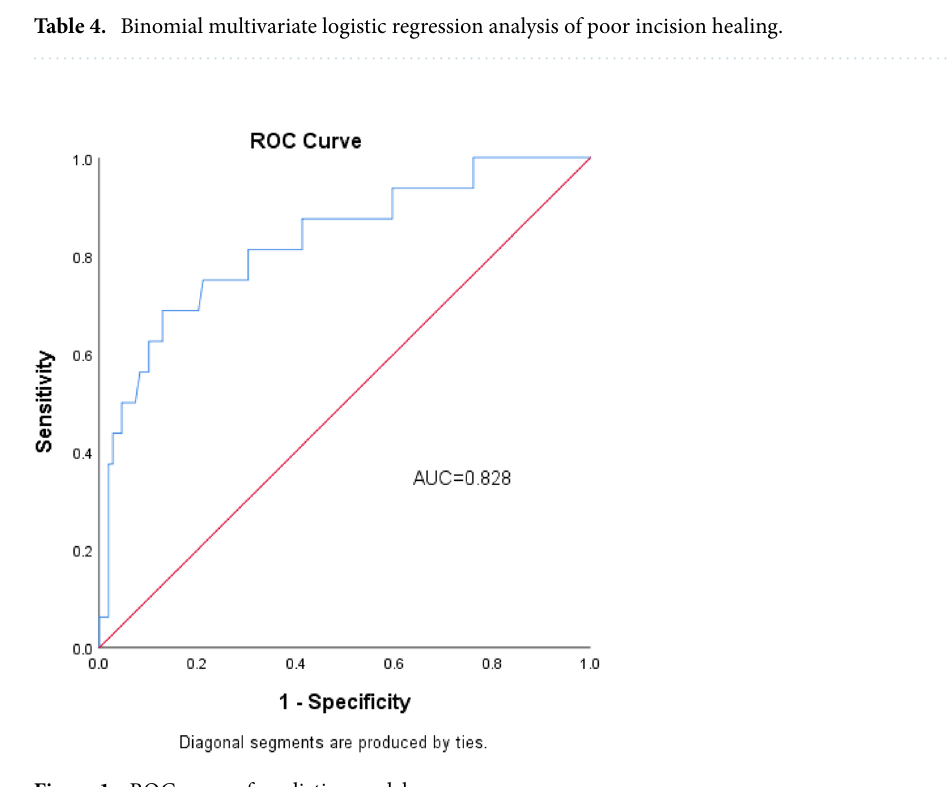
Figure 1. ROC curve of predictive